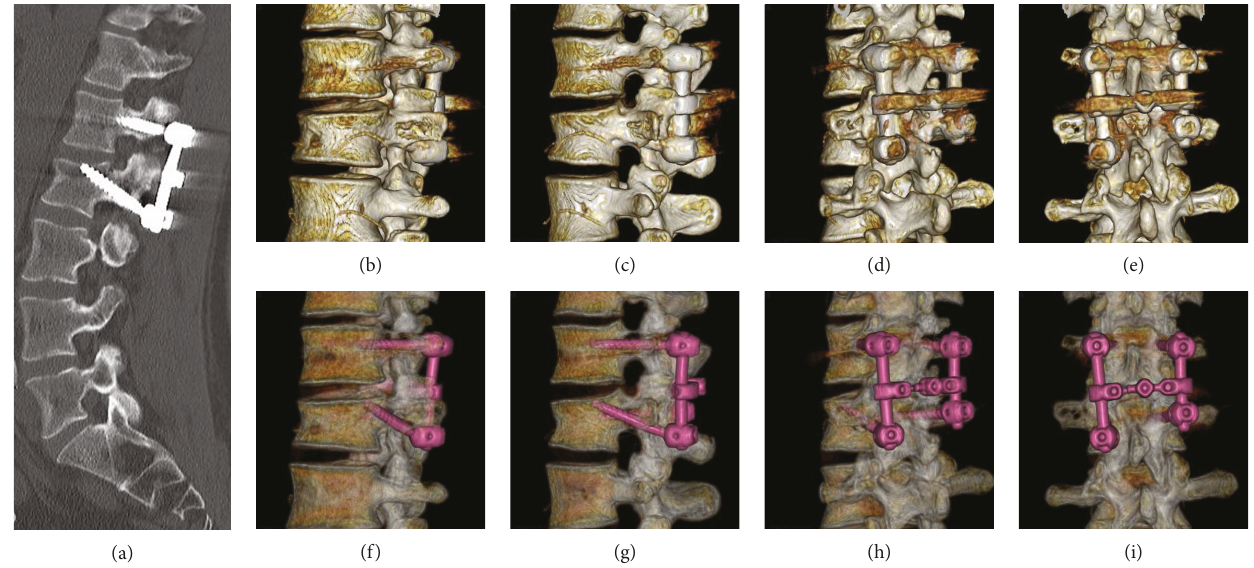
Figure 4: Postoperative computed tomography (CT) of the lumbar spine. (a) Left parasagittal CT obtained 6 months after surgery showing good reduction and fracture healing of the L2 vertebral body and pedicle, with proper CBT screw placement. (b, f) 3D-CTs obtained 1 year after surgery from the left anterolateral view, (c, g) left lateral view, (d, h) left posterolateral view, and (e, i) posterior view showing the screw trajectories in 3D view and complete bone union of the fracture, including the L2 vertebral body, pedicle, and transverse process. (f – i) Bone density was reduced to observe screw